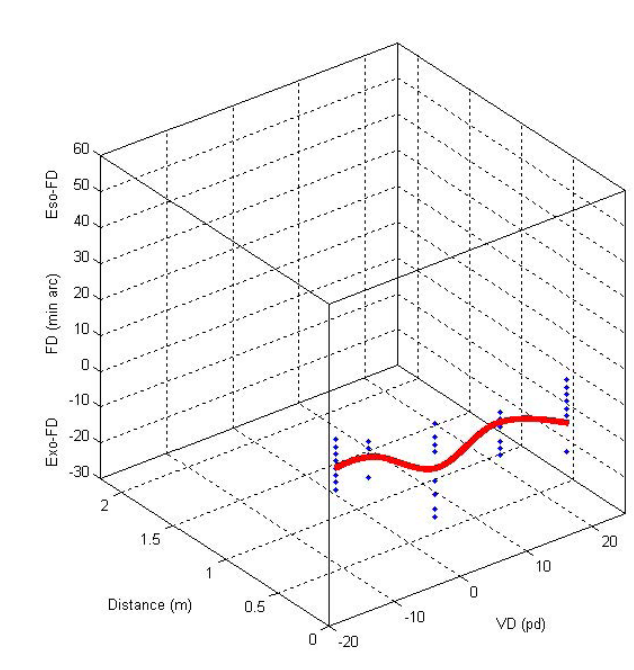
Figure 3. The same data, as in Figure 2a for Subject 1, is included to illustrate the transition from a 2-space to a 3-space. Here only results for 0.25 m are shown but one could easily include similar data for other stimulus distances such as 0.5, 1 and 2 m as for Figure